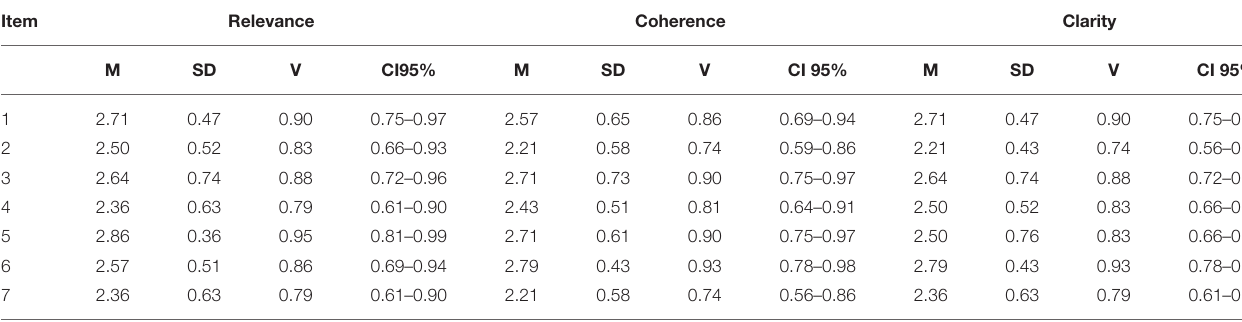
TABLE 3 | Aiken’s V for assessing the clarity, consistency and relevance of the COVID-VCBS items. Item Relevance Coherence